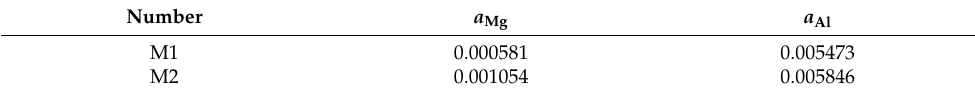
Table 4. Activity of Mg and Al in sample M1 and sample M2.